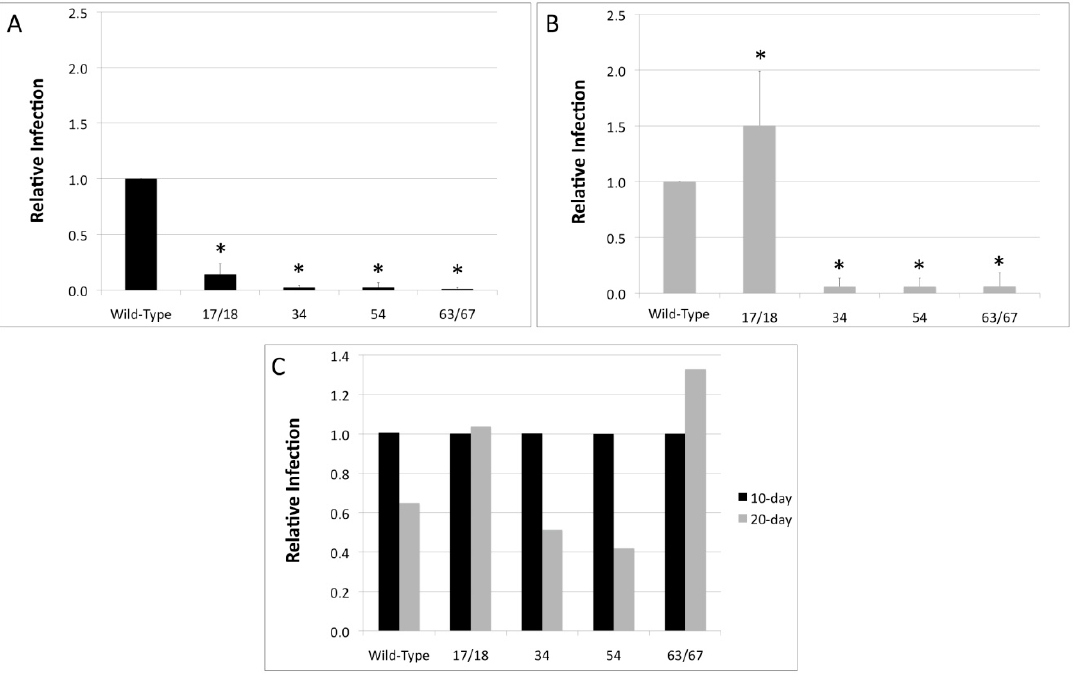
Figure 4. Mutations in HPV18 E1ˆE4 affect viral infectivity. HaCaT cells were infected with WT or mutant HPV18 virus, harvested at either day 10 or day 20 of tissue growth, at a multiplicity of infection (MOI) of 10. Forty-eight hours post infection (h.p.i.) mRNA was harvested and levels of the E1ˆE4 splice transcript were determined by RT-qPCR. ( A ) To measure the relative difference in infectivity between 10-day WT HPV18 and the 10-day mutant HPV18 viruses, the level of infection of 10-day WT HPV18 is set equal to one; ( B ) To measure the relative difference in infectivity between 20-day WT HPV18 and the 20-day mutant HPV18 viruses, the level of infection of 20-day WT HPV18 is set equal to one; ( C ) To compare the relative difference between the infection of 10-day virus and 20-day virus for WT HPV18 and each of the HPV18 mutants, each 10-day infection level was set equal to one. ( A – C ) Are representative of at least three individual infections utilizing at least two different virus preparations. Bars represent standard deviation. An asterisk (*) denotes significance by students t -test. Statistical significance was defined at p ≤ 0.05.